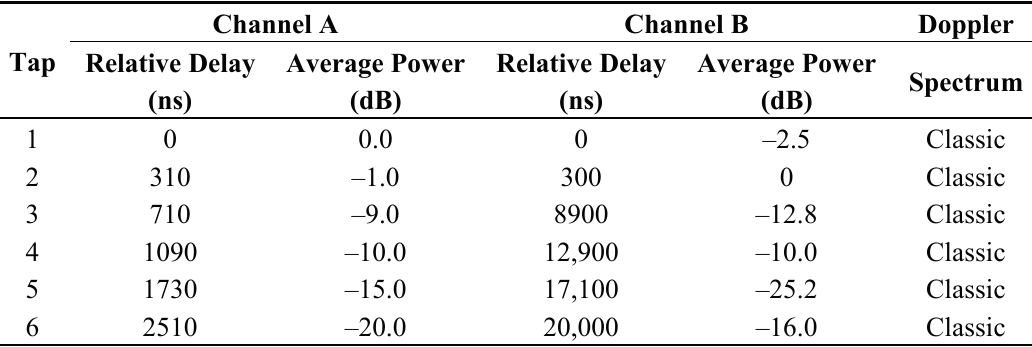
Table 2. ITU’s vehicular test environment